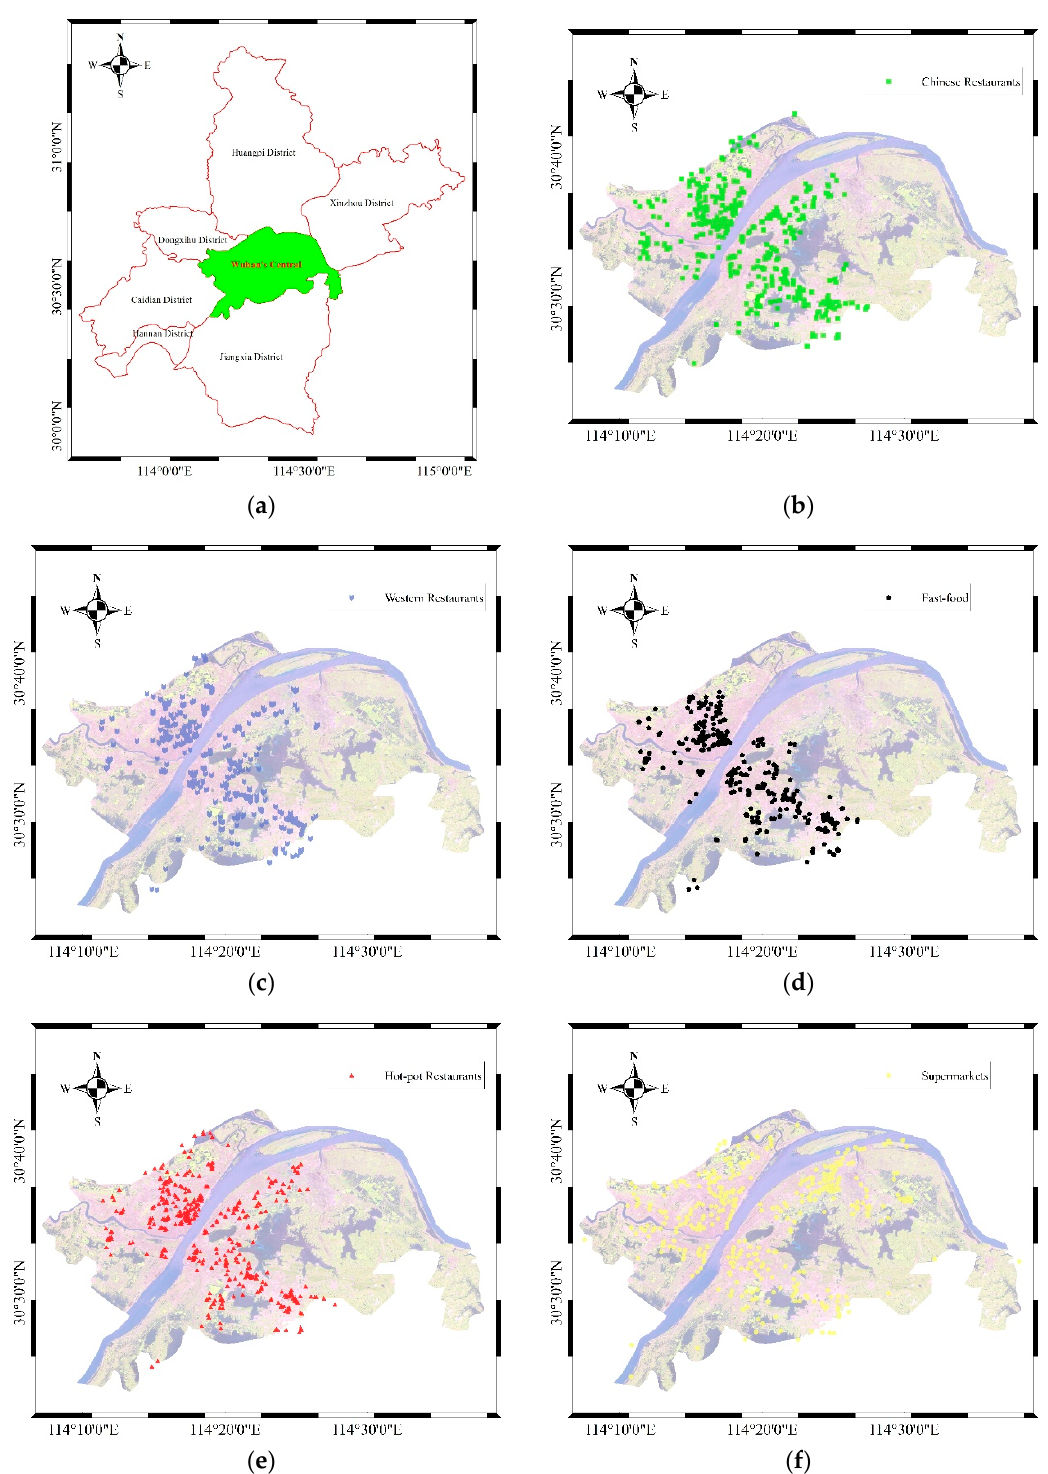
Figure 10. Spatial distribution of restaurants in Wuhan. ( a ) Wuhan’s Central District. ( b ) Chinese restaurant. ( c ) Western restaurant. ( d ) Fast food. ( e ) Hot-pot restaurant. ( f ) Supermarket. Located at the intersection of the middle reaches of the Yangtze River and the Han River, Wuhan is divided into three districts, i.e., Wuchang, Hankou and Hanyang, and sprinkled with many lakes in the central district. It can be observed that many restaurants are divided or gathered by the natural topographic conditions and water systems. At first, the spatial clustering analysis of the five types of restaurants is performed using the CDHC algorithm. Then, the clustering result is subject to the overlay analysis, which gives rise to a thematic map shown in Figure 11a.